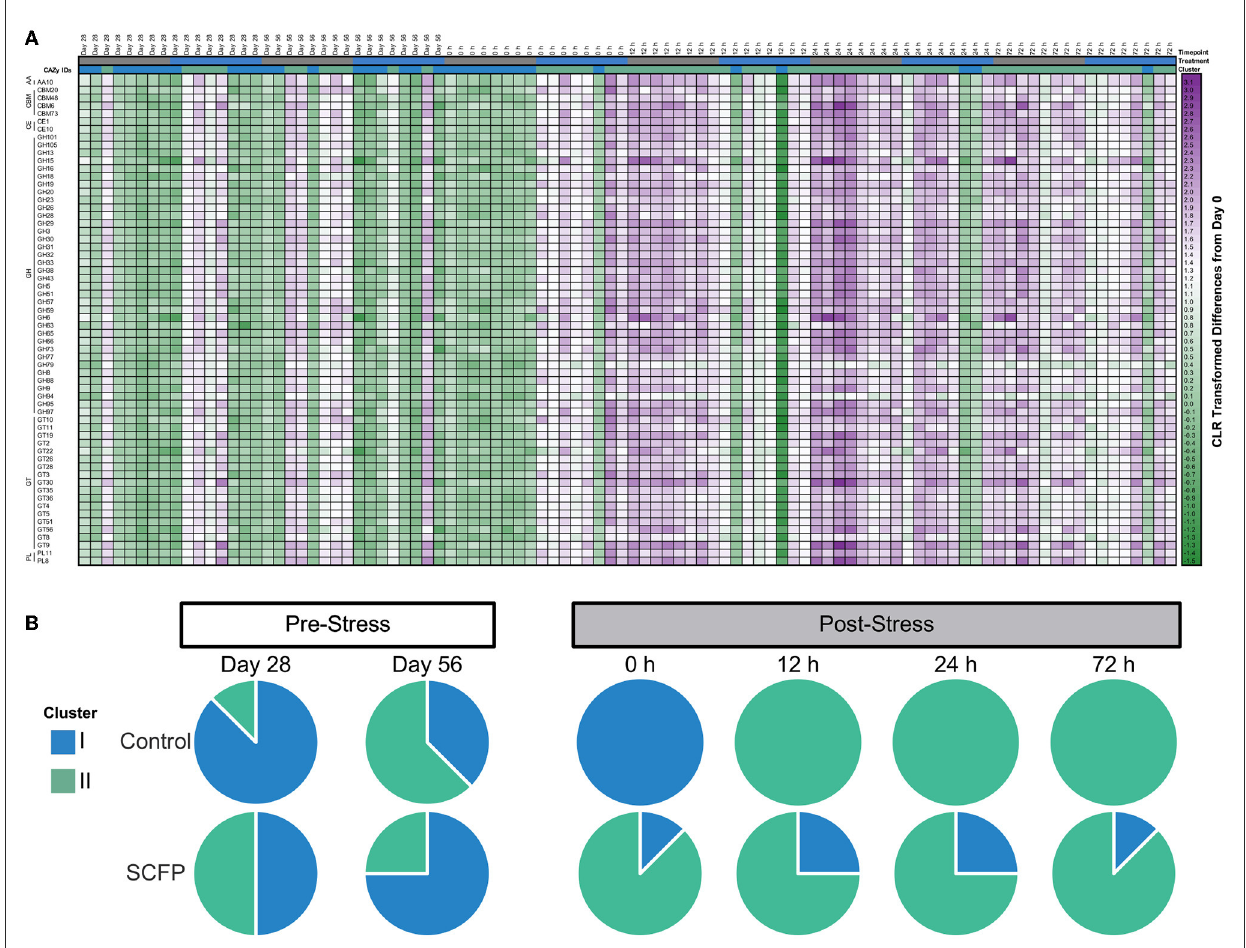
FIGURE6 Functional potential is differentially impacted by treatment and stress in SCFP and Control horses. (A) Heatmap of centered log-ratio relative abundance of carbohydrate active enzymes (CAZy) families detected in fecal samples of horses. (B) Pie charts represent the presence of samples across different clusters for Control and SCFP groups across time. AA, Auxiliary Activity Family; CBM, Carbohydrate-Binding Module Family; CE, Carbohydrate Esterase Family; GH, Glycoside Hydrolase Family; GT, Glycosyl Transferase Family; PL, Polysaccharide Lyase